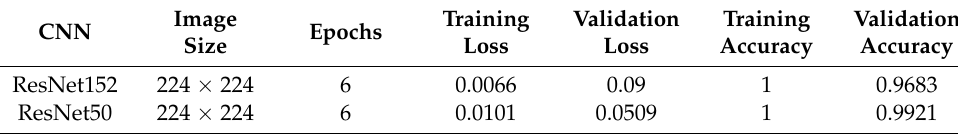
Table 3. Training